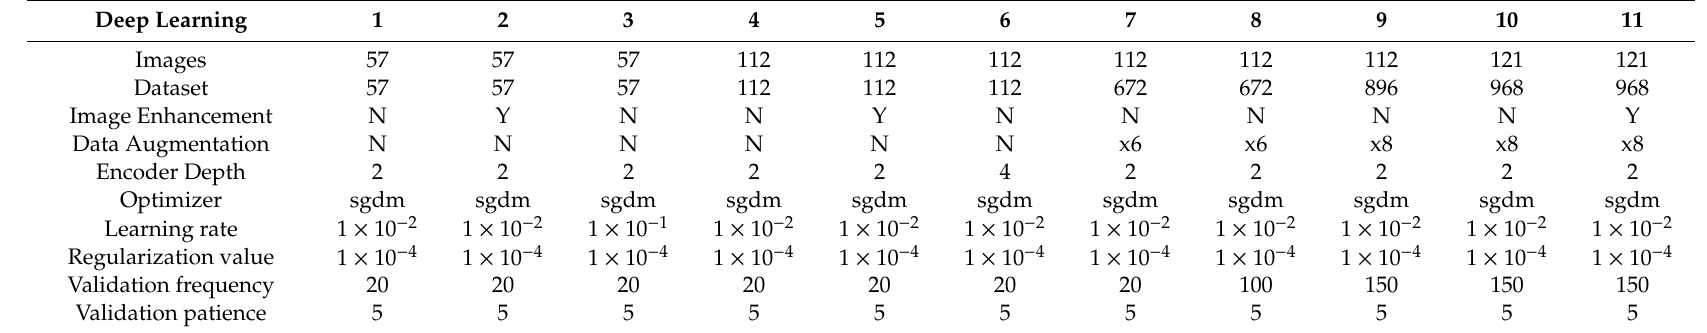
Table A1. Deep-learning model’s parameters (1 / 2).